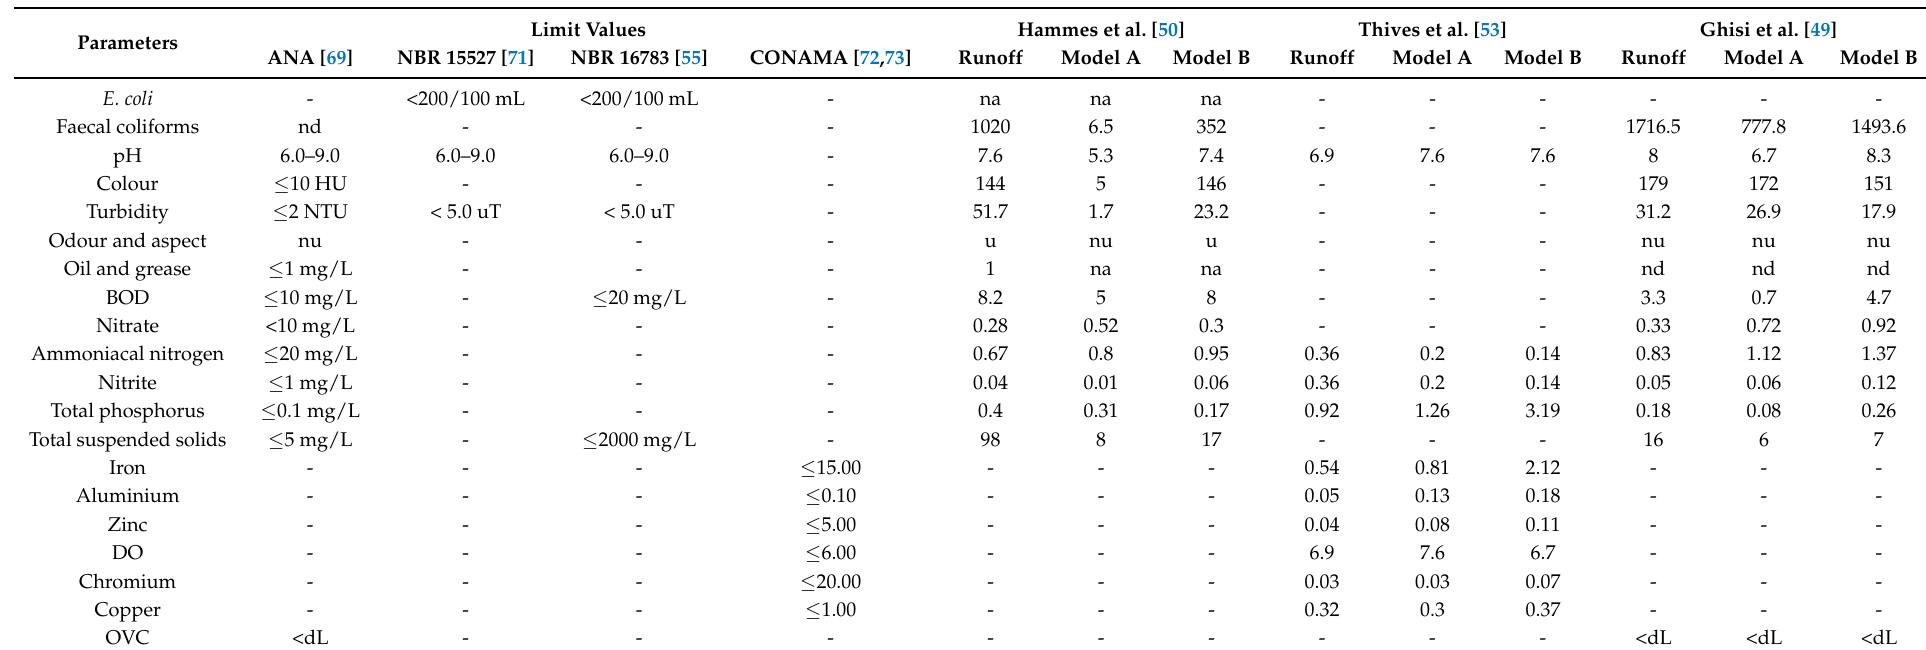
Table 4. Qualitative parameters of the selected